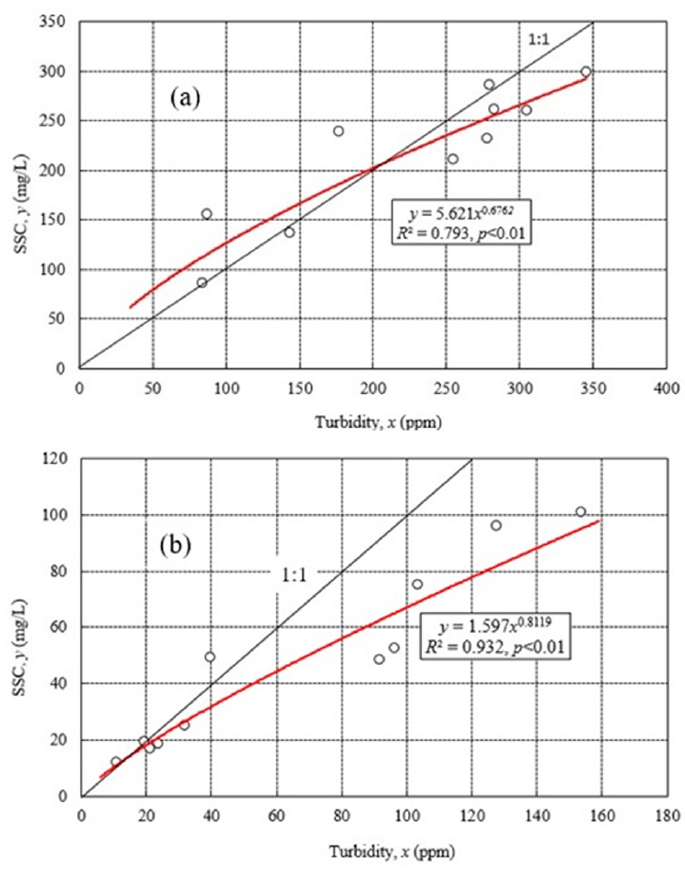
Figure 2. Relations between turbidity (ppm) and SSC (suspended sediment concentration; mg/L) at ( a ) site PLS and ( b ) the coastal region off the Yukon delta front. At sites B1 to B10 in Figure 1, which were located at less than 30 km from the delta front near site EMK, profiler observations and water and sediment samplings were performed by boat on 6 September 2009 and 22 June 2010. A TCTD (turbidity-conductivity-temperature- depth) profiler (model ASTD687, JFE Advantech, Co., Ltd., Japan) was then utilized for the vertical measurements at 0.1 m pitch. The B5–B8 line and B6–B10 line correspond to two longitudinal lines offshore from the fan-shaped Yukon River